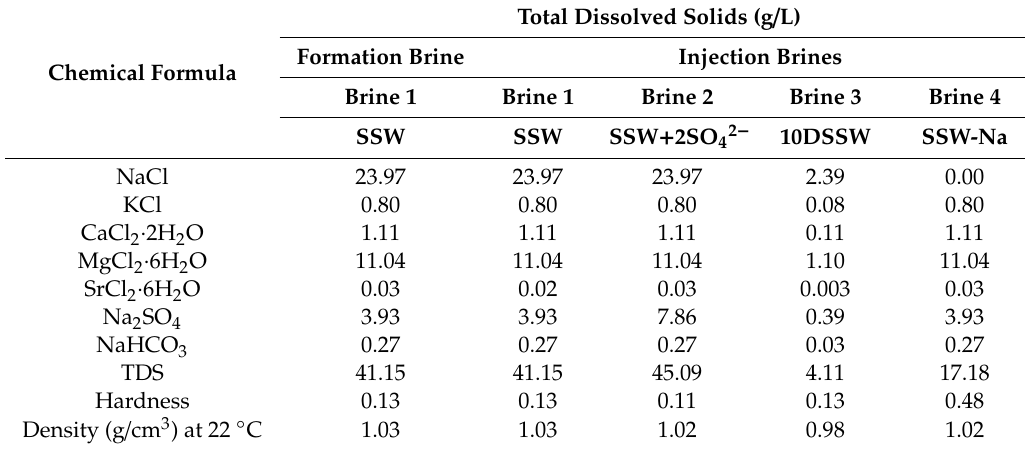
Table 2. Chemical composition of formation and injection